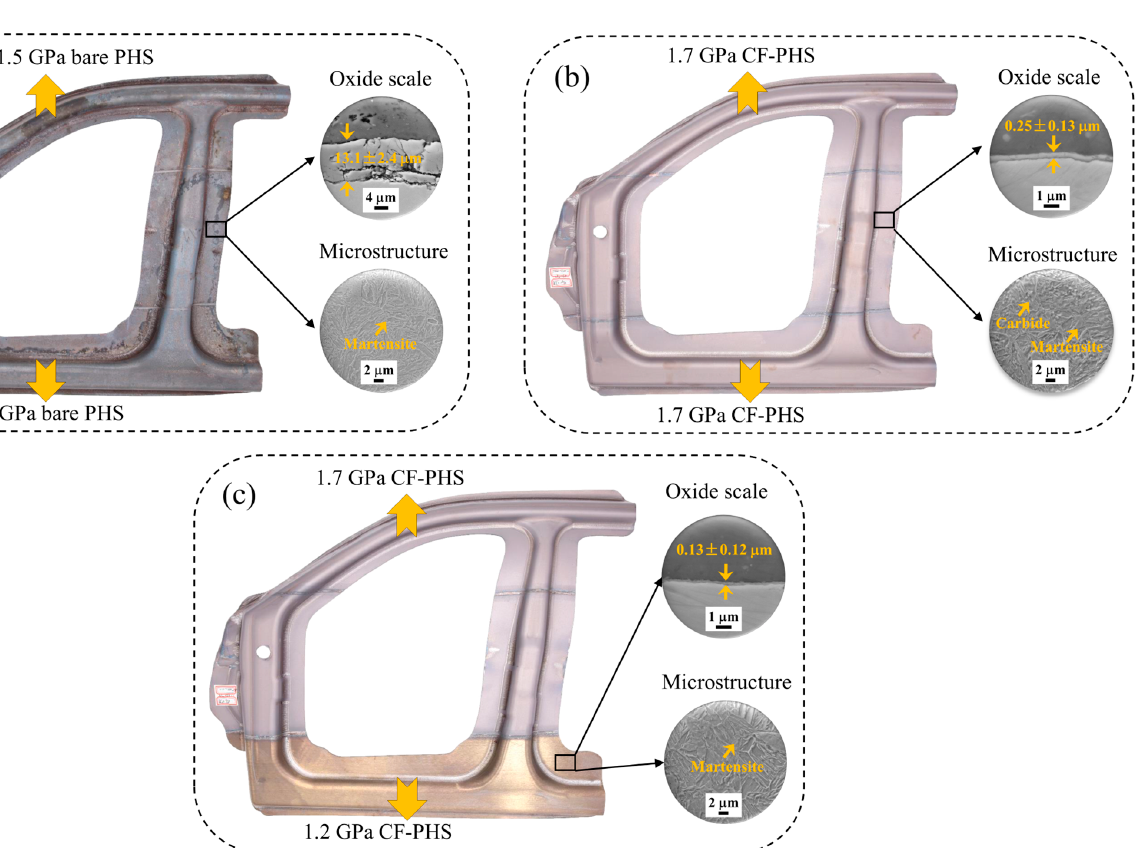
Figure 11. Component level three-point bending curves of prototype door impact beams for 1.7 GPa CF-PHS and 1.5 GPa Al-Si-coated PHS.